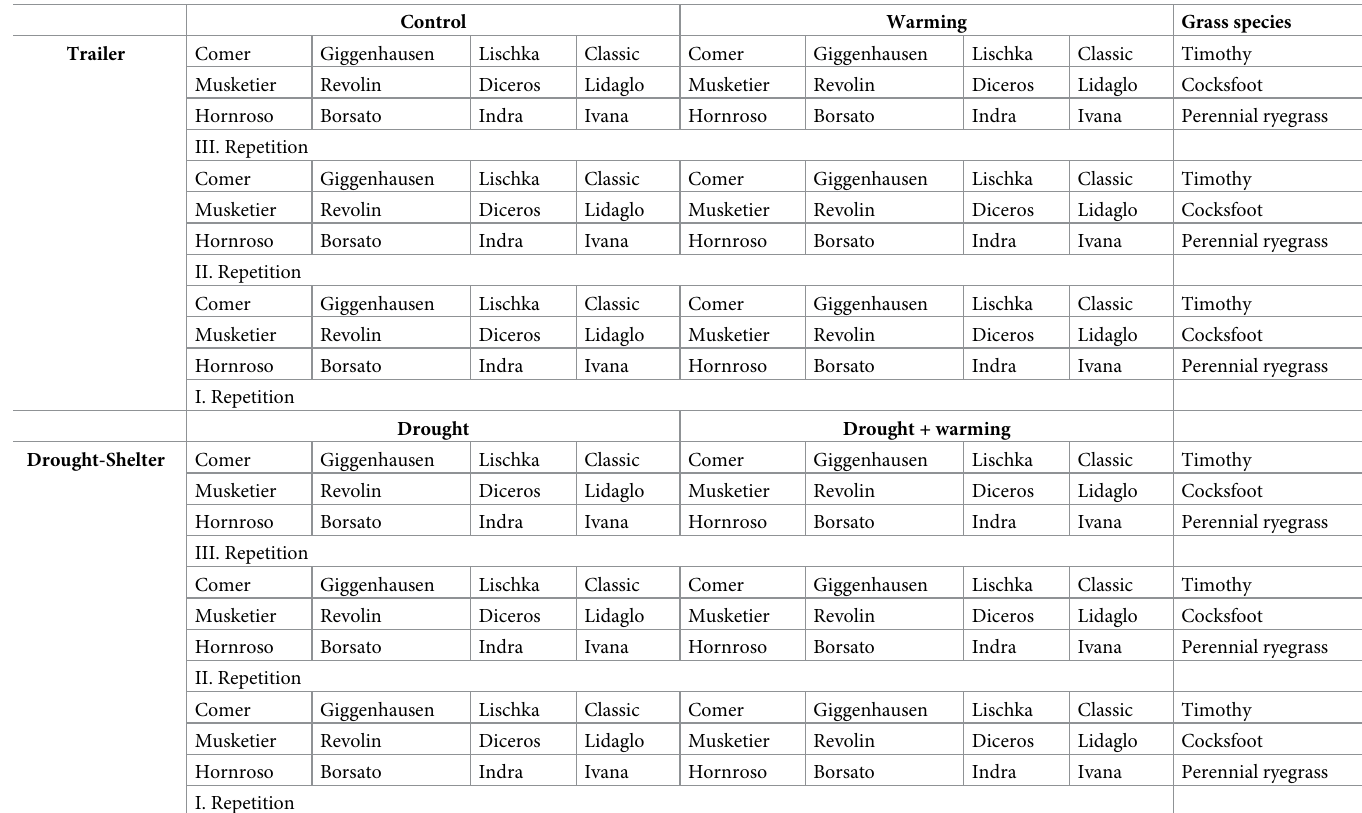
from the three grass species timothy, perennial ryegrass and cocksfoot (4 � 3 = 12 plots). Within each treatment three repetitions were conducted on a total of 36 plots (see Table 1). Treatments During the investigation period from May 19 until June 23, 2017, the simulation of drought (-stress) and/or elevated air temperature was conducted in three different treatments and one control (Fig 1). Besides the control, the experiment comprised the treatments drought (rain Table 1. Experimental setup in Du¨rnast comprising respectively four different cultivars from the grass species timothy, cocksfoot and perennial ryegrass under three treatments and the control, three repetitions each, cocksfoot was excluded from this study since the pollen production was insufficient. Control Warming Grass species